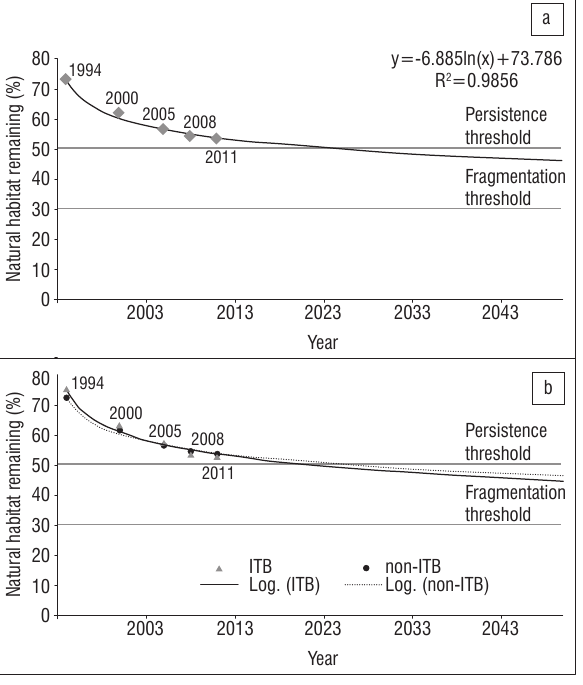
Figure 6: (a) Extrapolated rates of habitat loss in KwaZulu-Natal, assuming a business-as-usual scenario. The persistence threshold is reached once 50% of natural habitat is lost, beyond which there is a rapid decline in the probability of landscapes supporting viable populations. The fragmentation threshold is reached once 70% of natural habitat is lost, whereafter the spatial configuration of habitat patches becomes important for the persistence of remaining species. 43 (b) Extrapolated rates of habitat loss in the Ingonyama Trust Board (ITB) and non-ITB